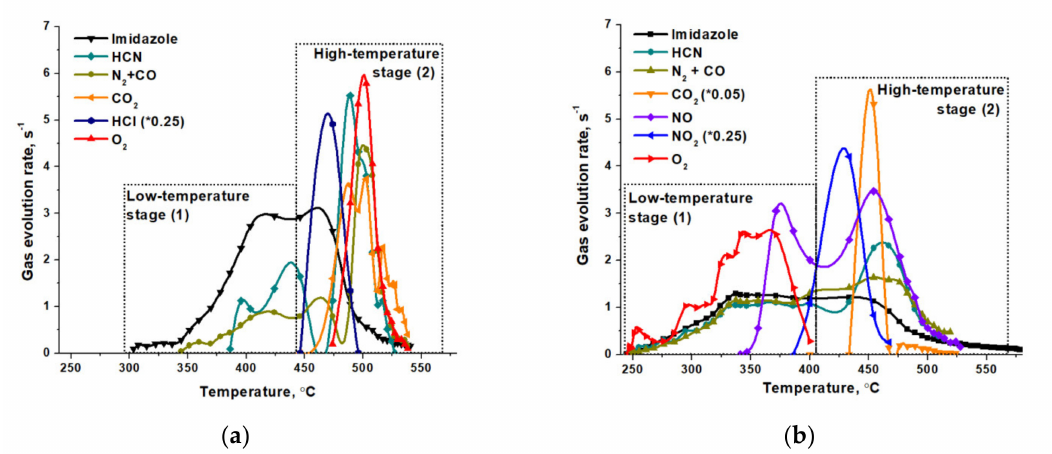
Figure 6. Mass spectrometry of gas released during the thermal decomposition of ( a ) [Ni(C 3 H 4 N 2 ) 6 ] (NO 3 ) 2 and ( b ) [Ni(C 3 H 4 N 2 ) 6 ](ClO 4 ) 2 complexes. The heating rate in air is above 100 ◦ C/s (*0.05 and *0.25—correlation